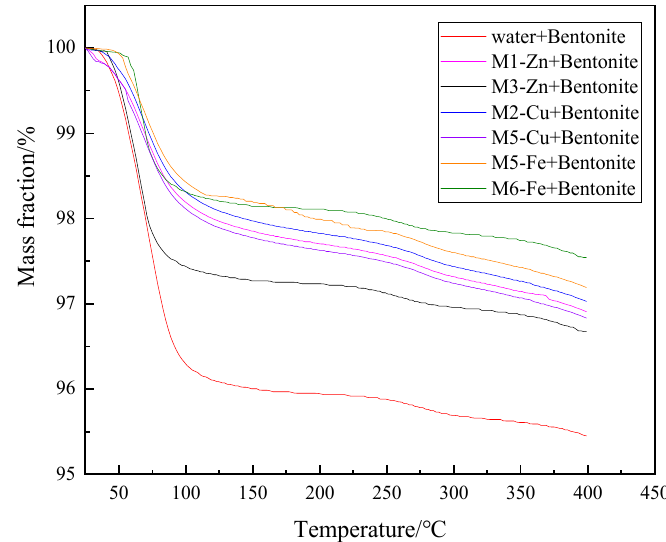
Figure 11. TGA curves of bentonite after different sample treatments.